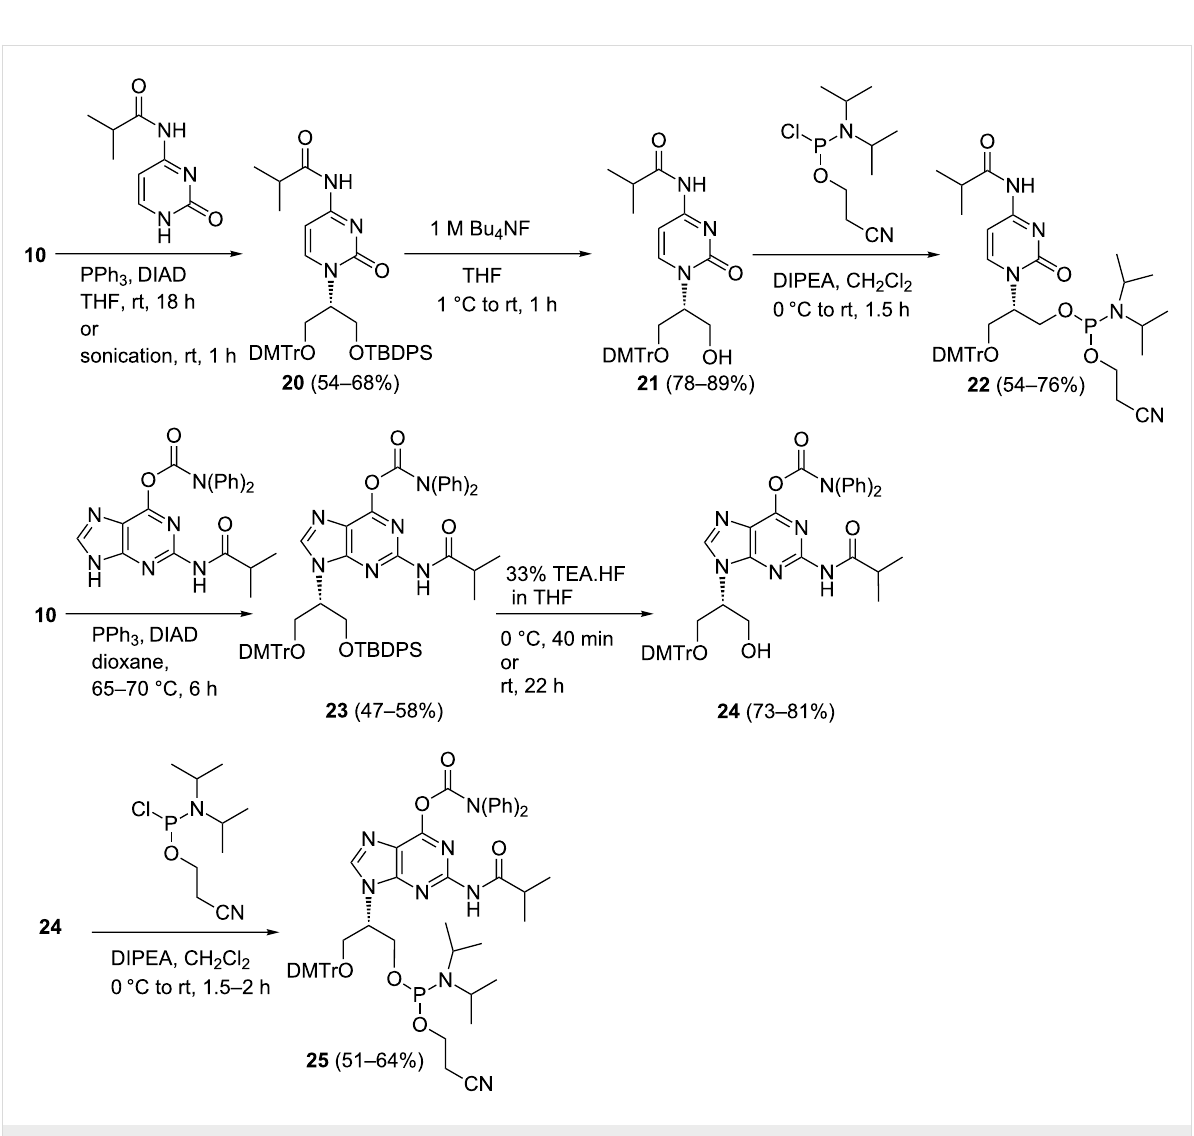
Scheme 3: Preparation of guanine- and cytosine-containing phosphoramidites of